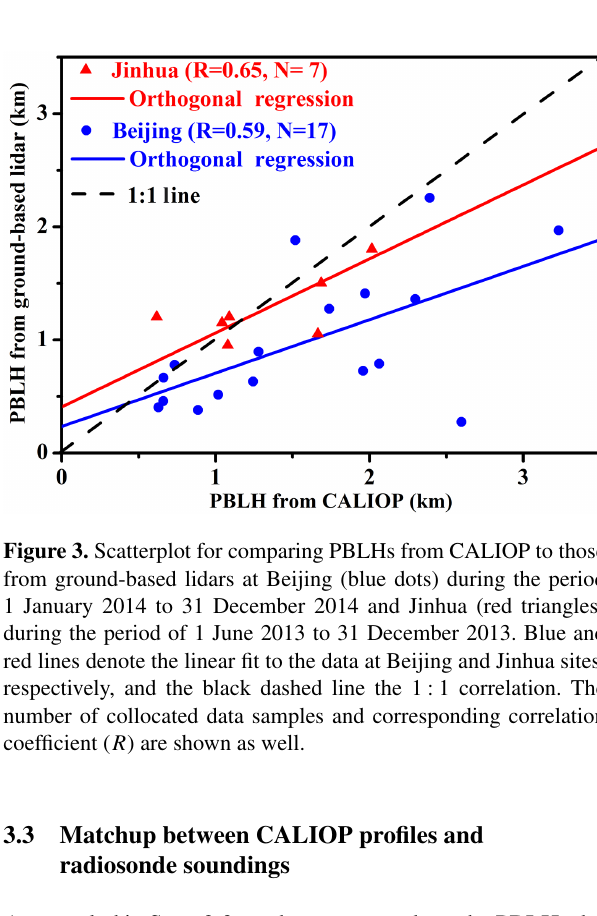
Figure 2. Curtain plot of attenuated backscatter coefficient as observed from CALIOP aboard CALIPSO on 15 January 2011. The black line indicates the derived PBLH (above ground level), and the grey line immediately on top of the blue region represents the terrain surface (directly extracted from CALIOP data). The red line in the inlet map corresponds to the ground track of CALIOP/CALIPSO over southeastern China.